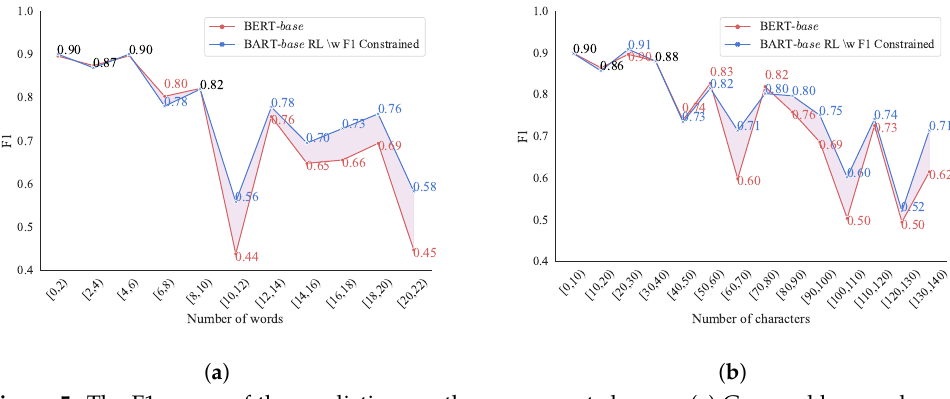
Figure 5. The F1 scores of the predictions as the answer gets longer. ( a ) Grouped by numbers of words. ( b ) Grouped by numbers of